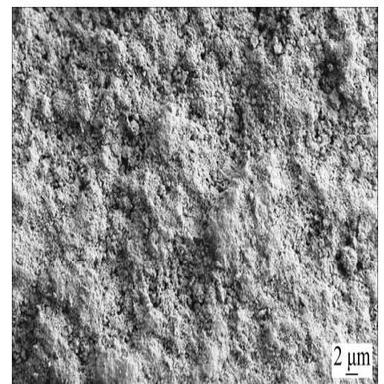
ESEM micrograph of nano B4C particles